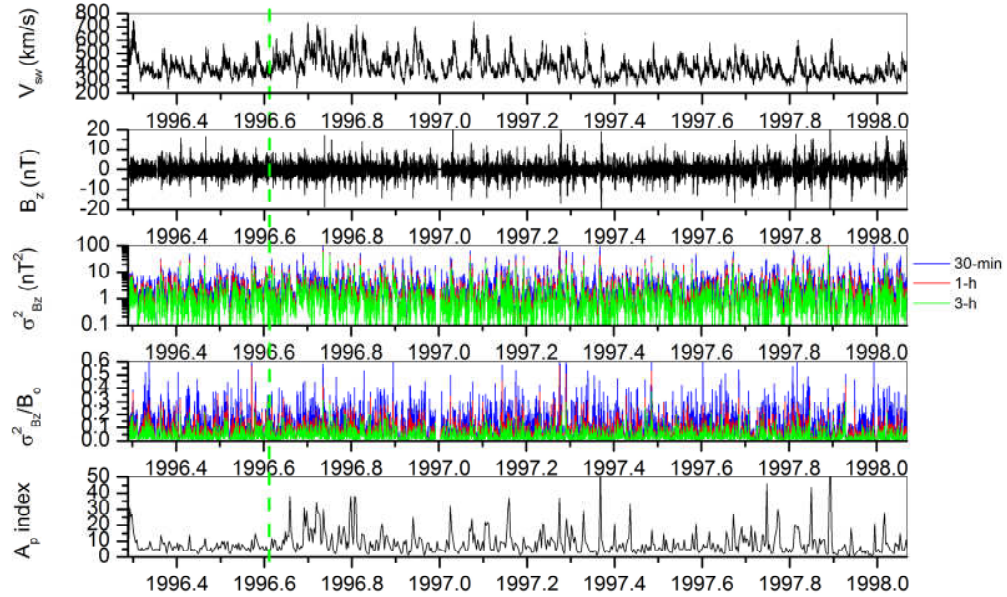
Fig. 6. The same format as in Fig. 4, but for MGA22. The SC22 minimum is indicated by a vertical dashed green line. Table 2. The B z variance and normalized B z variances for MGA22, MGA23, Ambleside HSS1 and HSS2 events. Nested variances (nT 2